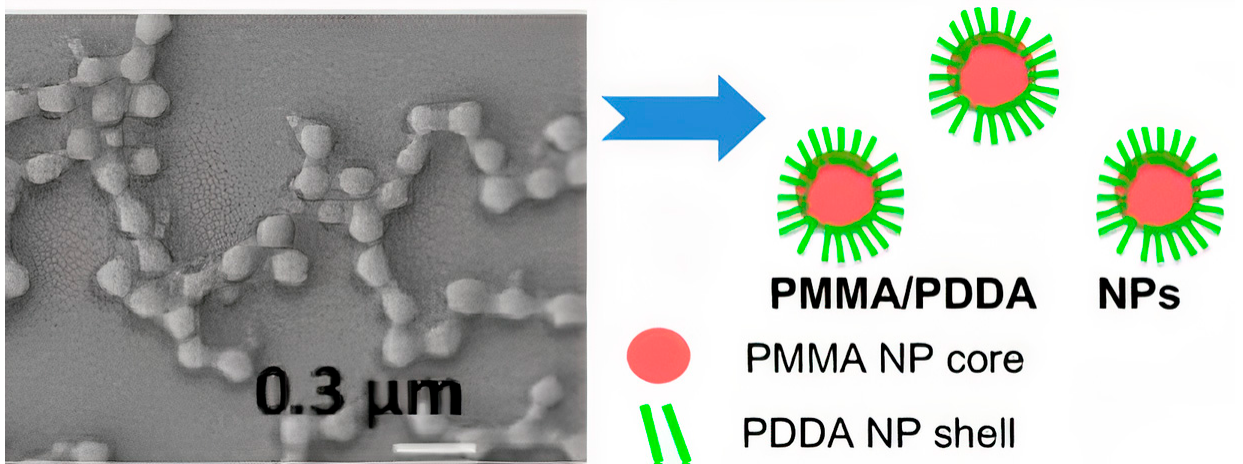
Figure 8. Scanning electron micrograph of poly (methyl methacrylate) PMMA/poly (diallyl dimethyl ammonium) chloride PDDA antimicrobial nanoparticles (PMMA/PDDA NPs) and schematic representation of their core − shell structure at low ionic strength. Reproduced from [17]. The NPs were obtained from emulsion polymerization of methyl methacrylate (MMA) in the presence of PDDA.